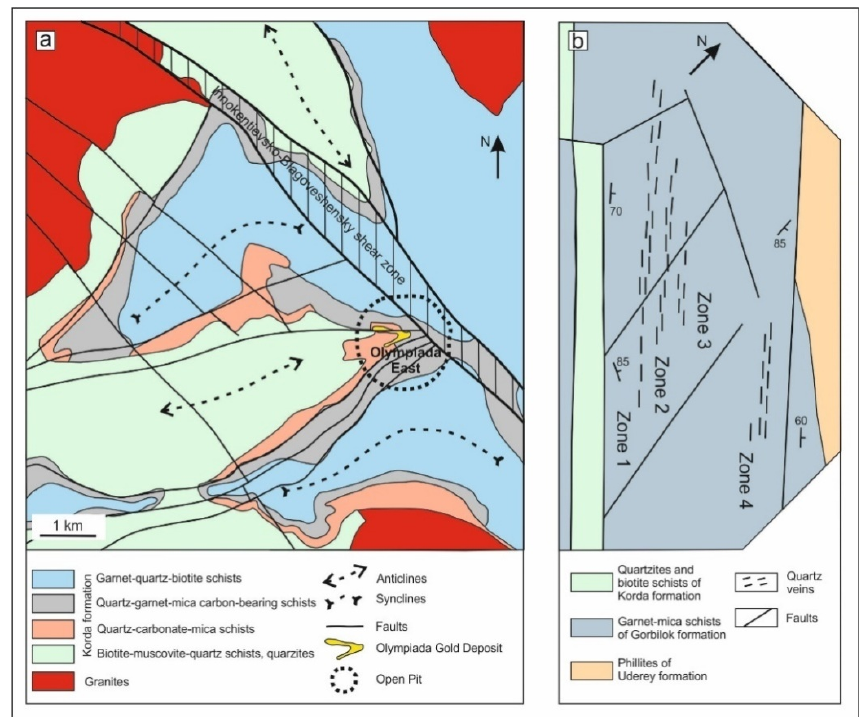
Figure 2. Simplified geological sketch of the ( a ) Olympiada ore field after [28] and ( b ) Eldorado deposit [30].